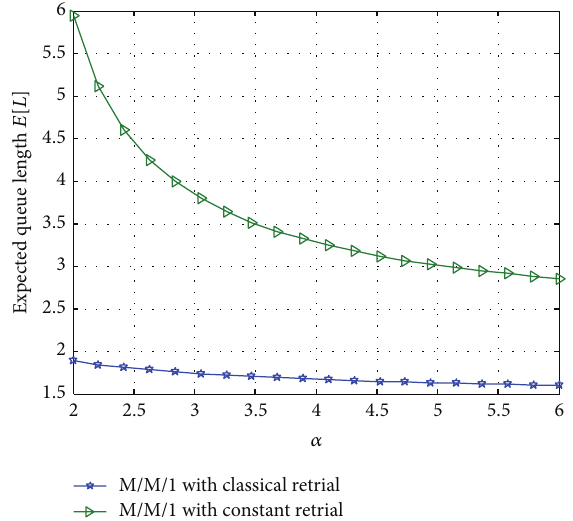
Figure 6: The effect of 𝛼 on 𝐸[𝐿] for two different retrial policies.